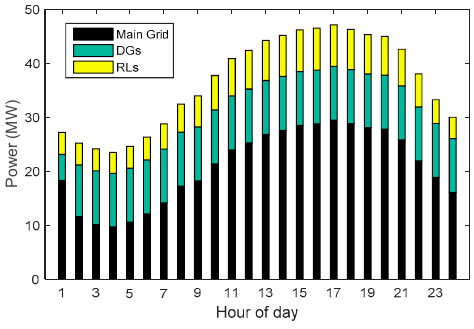
Figure 10. Energy resources scheduling results for Case 6.